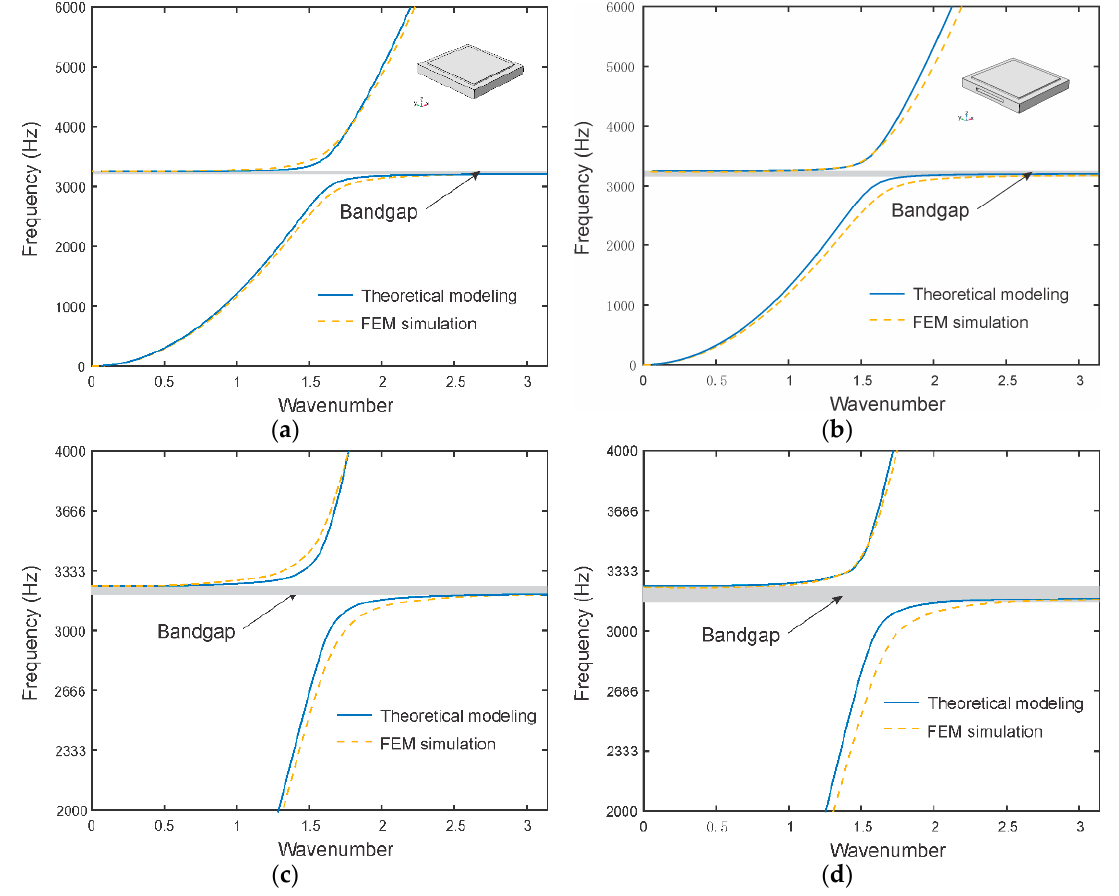
Figure 5. Dispersion curves. ( a ) Unit-cell without cavity; ( b ) Unit-cell with cavity of 25.38 × 12 × 1 mm 3 ; ( c ) Zoom in curves for unit-cell without cavity; ( d ) Zoom in curves for unit-cell with cavity.